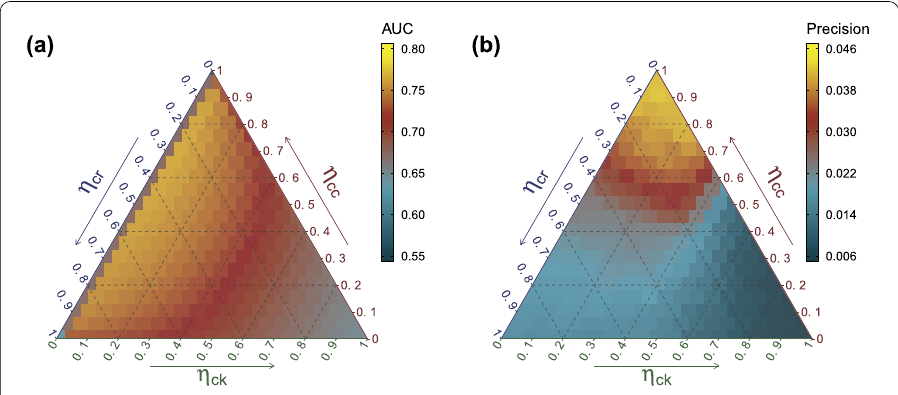
Figure 2 AUCandPrecisionvaluesofthe MAAmetricfordifferentvaluesofthecoefficients η c α . Varying the values of η cr and η ck , the third parameter η cc is naturally